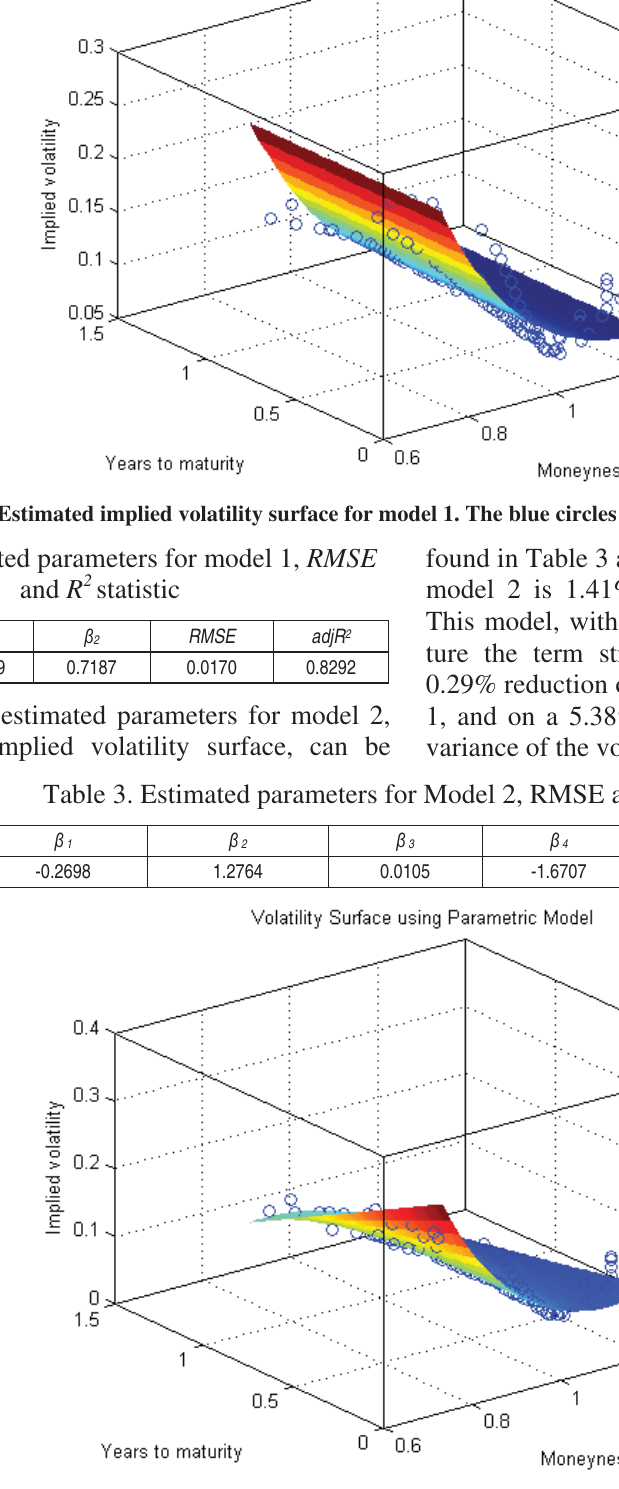
Fig. 3. Estimated implied volatility surface for model 2. The blue circles are the observed